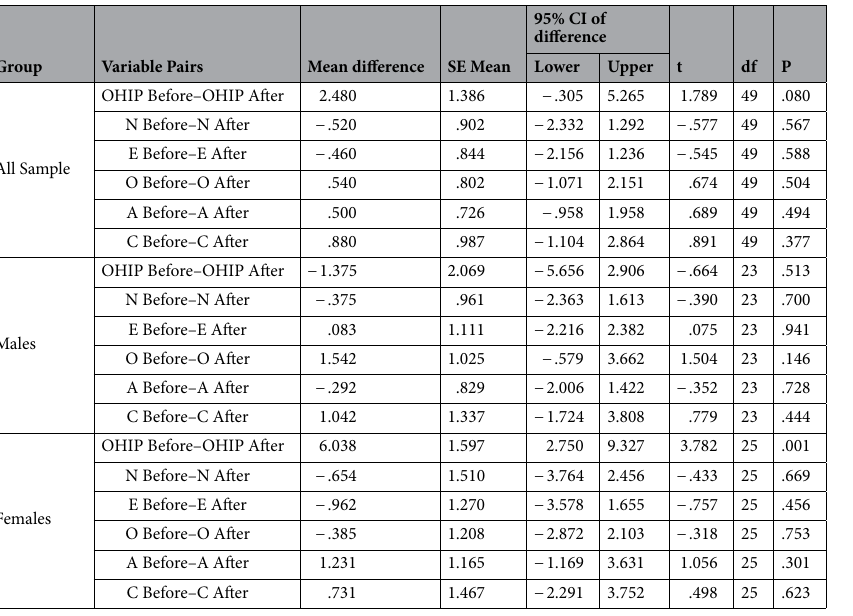
Table 3. Comparison of OHIP and NEO-FFI scores before and after treatment among the study sample (n = 50, 26 females and 24 males). SE Mean = Standard error mean, CI = Confidence intervals, t = t statistics, df = Degree of freedom, P = Significance probability value, OHIP = Oral Health Impact Profile score, Before = Before treatment, After = After treatment, N = Neuroticism, E = Extraversion, O = Openness, A = Agreeableness, C =